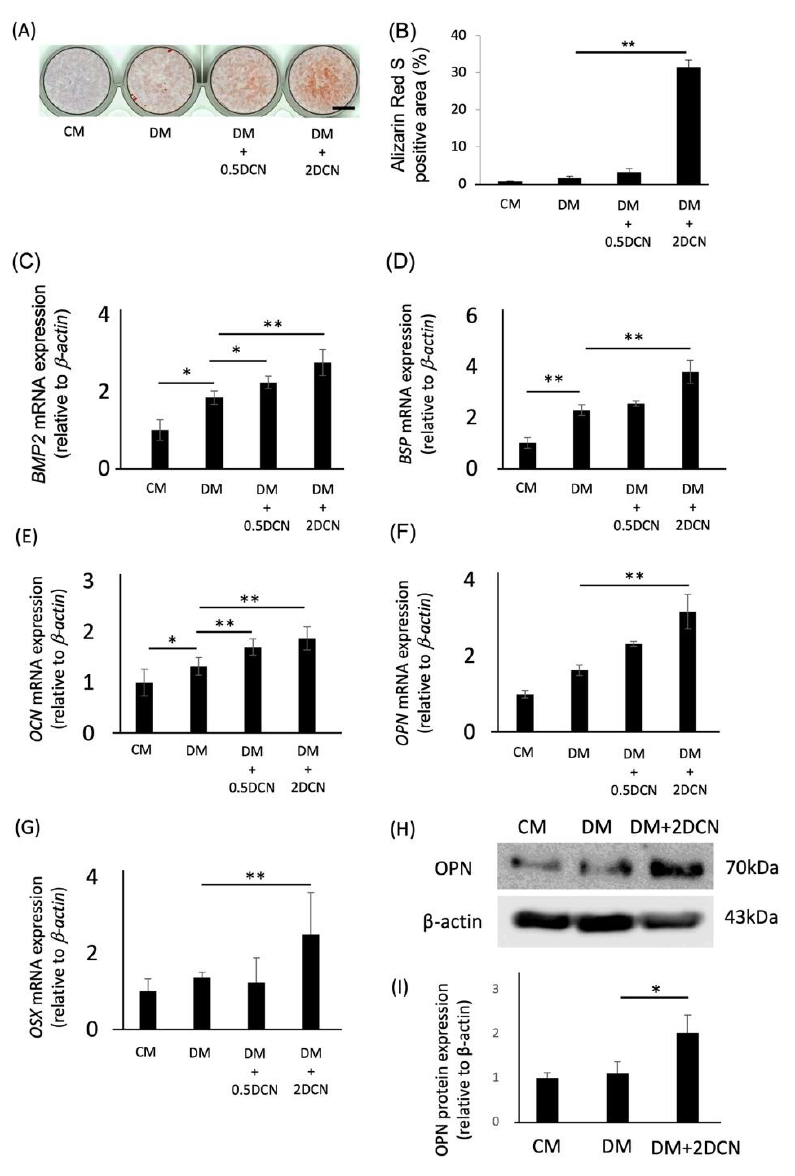
Figure 2. Effects of DCN on the osteoblastic differentiation of HPDLSCs. ( A ) HPDLSCs were cultured in 10% FBS/ α -MEM (CM), CM with 1.5 mM CaCl 2 (DM), DM on a 0.5 µ g/mL DCN coating (DM + 0.5 DCN), or DM on a 2 µ g/mL DCN coating (DM + 2 DCN) for 2 weeks. Alizarin red S staining was performed to evaluate the mineralization of HPDLSCs. Bar = 500 µm. ( B ) The graph shows the quantification of Alizarin red S-positive areas. ( C – G ) Quantitative RT-PCR was per- formed to analyze the gene expression of BMP2 ( C ), BSP ( D ), OCN € , OPN ( F ), and OSX ( G ) in HPDLSCs cultured under the same conditions for 7 days ( C – F ) or 12 h ( G ). ( H , I ) HPDLSCs were cultured in CM, DM, or DM + 2 DCN for 7 days. ( H ) Western blot analysis was performed to deter- mine the expression of OPN. -actin was used as a loading control. ( I ) The graph shows the quanti- fication of OPN expression. Normalization of protein expression was performed against -actin ex- pression. Values are the mean ± SD of three indepenDent. experiments. ** p < 0.01, * p < 0.05.